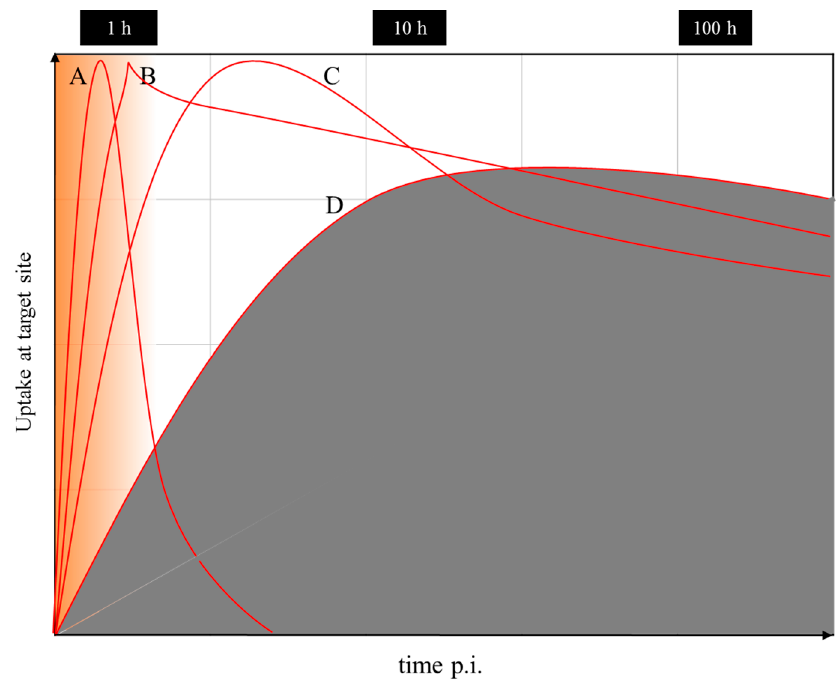
Figure 17. Uptake kinetics of a hypothetical radiotherapeutic compound labelled with, for example, 90 Y, 177 Lu or 225 Ac, in the target tissue is given in grey. Note the logarithmic time scale. ( A ) Example of fast accumulation and fast clearance from the target tissue. ( B ) Example of fast accumulation and slow release. ( C ) Example of medium accumulation and medium release kinetics. ( D ) Example of slow accumulation and slow release. The region of uptake kinetics, which can be covered by a 68 Ga-labelled analogue, is given in orange.